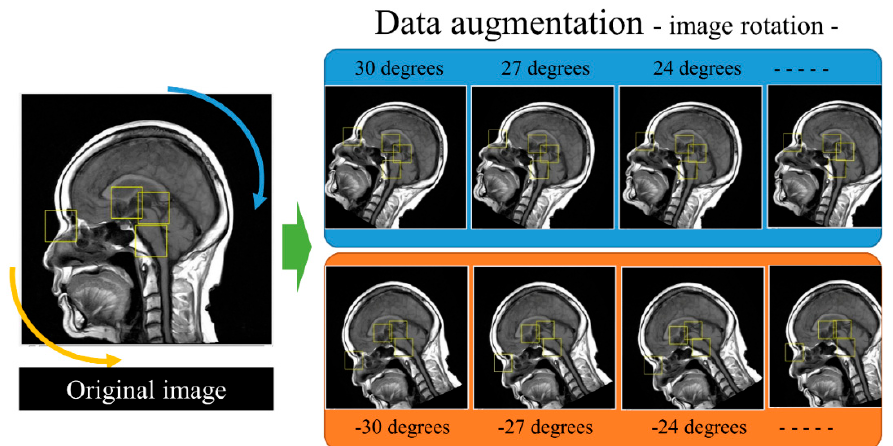
Figure 3. The procedure for data augmentation of the training datasets. The original images and supervised bounding boxes were rotated from − 30 to 30 degrees in 3-degree steps.